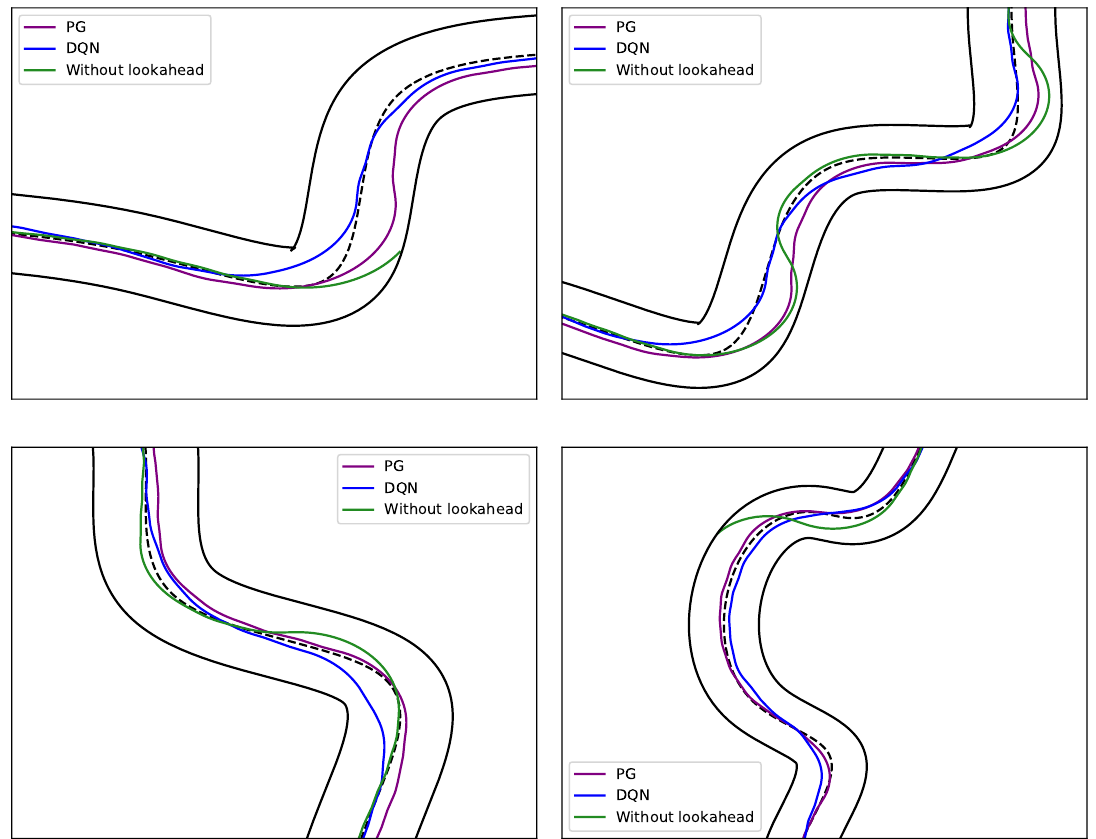
Figure 6. Comparison of Agents with and without lookahead